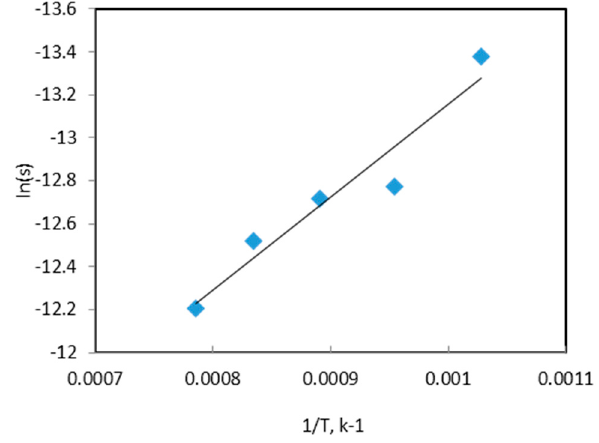
Figure 20. Arrhenius plot for sintering of NiWO 4 using laser flash unit.